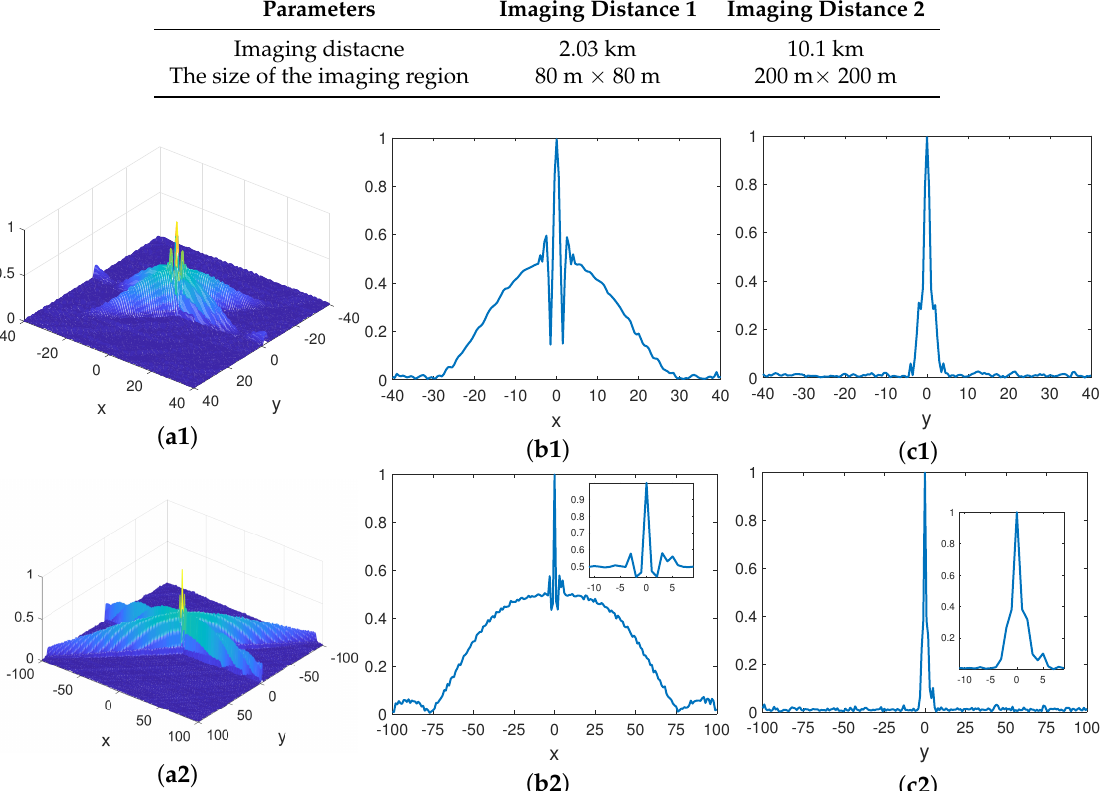
Figure 10. Space correlation function of bi-static MSCI under different imaging distance. ( a 1, a 2) The space correlation function of bi-static MSCI under different imaging distance 2.03 km and 10.1 km; ( b 1, b 2) the X-axis profile of the space correlation function of bi-static MSCI under different imaging distance 2.03 km and 10.1 km; ( c 1, c 2) the Y-axis profile of the space correlation function of bi-static MSCI under different imaging distance 2.03 km and 10.1